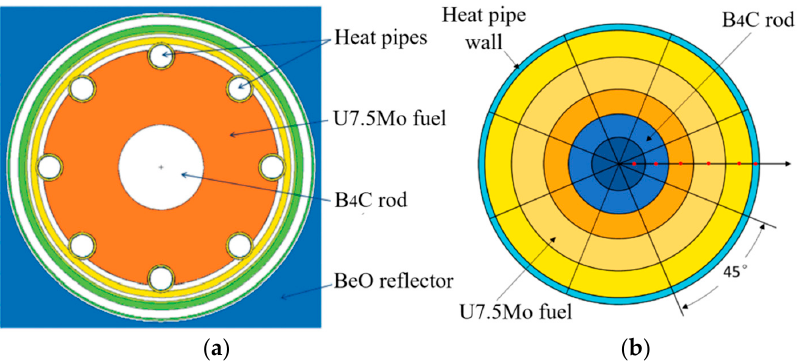
Figure 14. KRUSTY reactor core heat transfer model: ( a ) reactor core and ( b ) core model.